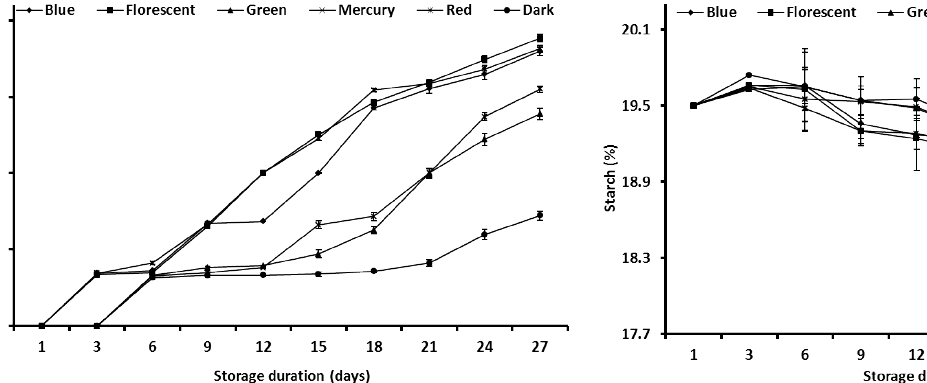
Fig. 3: Effect of different light sources on starch (%). Vertical bars show ±SE of means (n=3). The interaction between storage duration and light sources was significantly different at p ≤